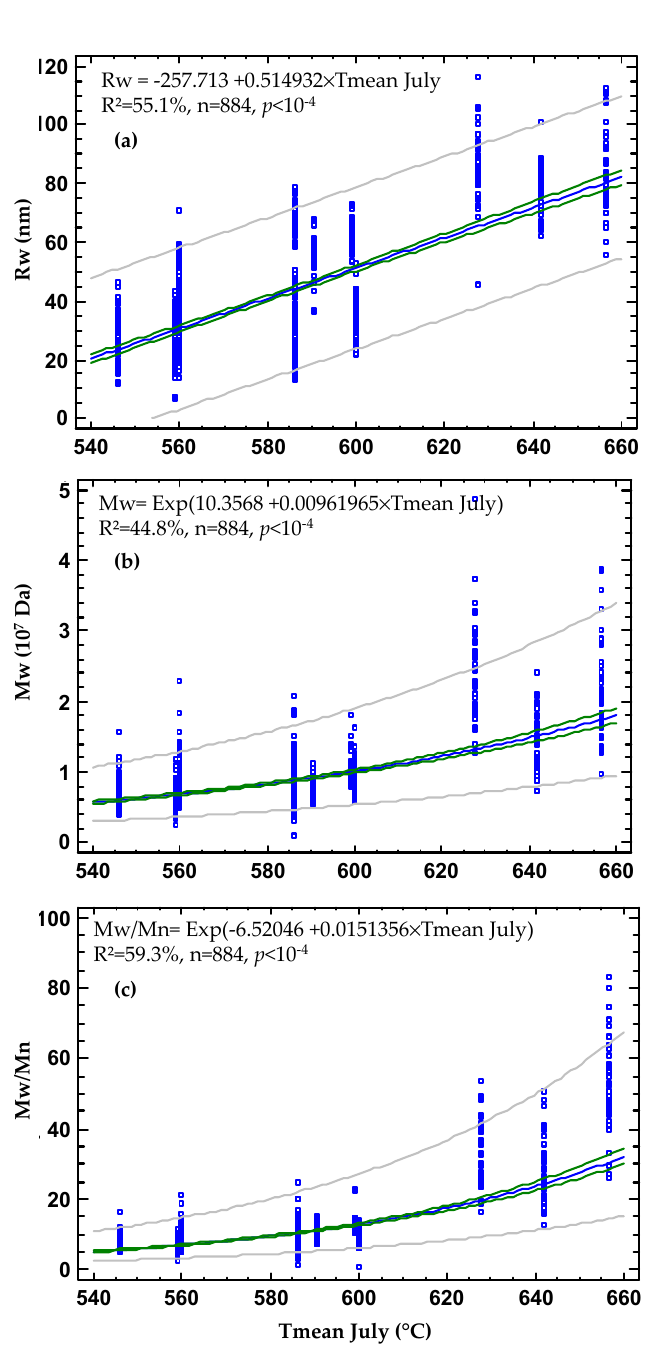
Figure 2. Regressions between the characteristics of the glutenin polymers, measured using Asymmetric Flow Field-Flow Fractionation Multi-Angle Laser Light Scattering (A4F-MALLS), and the cumulative daily mean temperatures (°C) of July (noted Tmean July) in the 11 wheat trial locations. ( a ) Rw of polymers (nm), ( b ) Mw of polymers (Da), and ( c ) PI of polymers (PI = Mw/Mn). Two locations with similar Tmean values (July, Verneuil l’Etang 2005: 586 °C and Mons en Pévèle 2009: 586.1 °C) are not separated on the figures. R 2 : percentage of phenotypic variance.